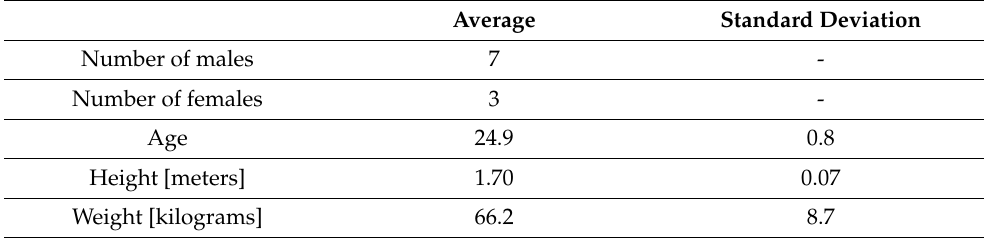
Table 4. Statistics of subjects participating in EMG test.